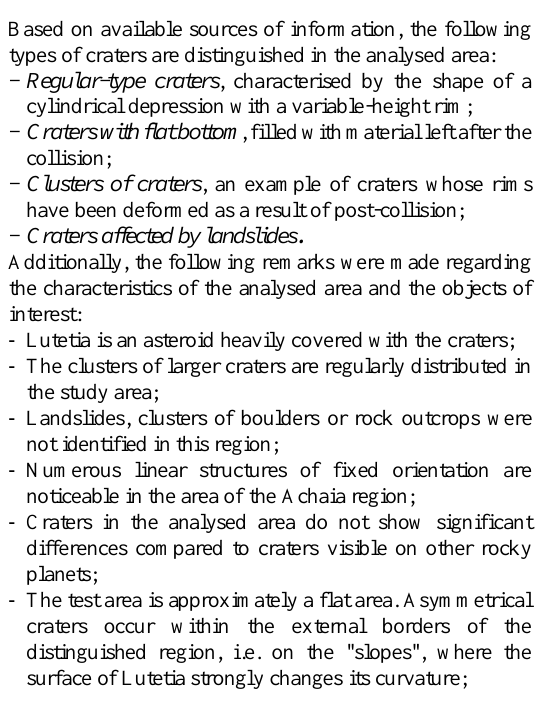
Figure 2. Randomly selected cells and the results of the visual interpretation carried out in Achaia